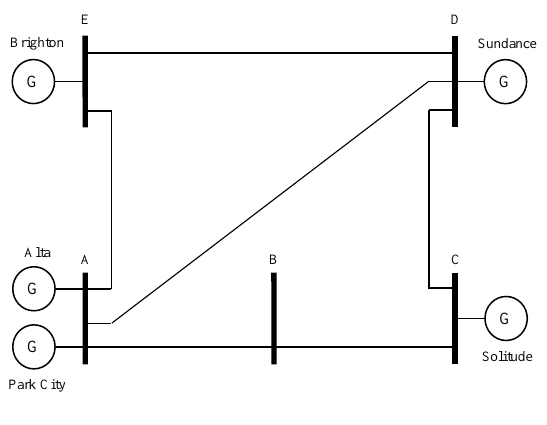
Figure 1. The PJM 5-bus system.